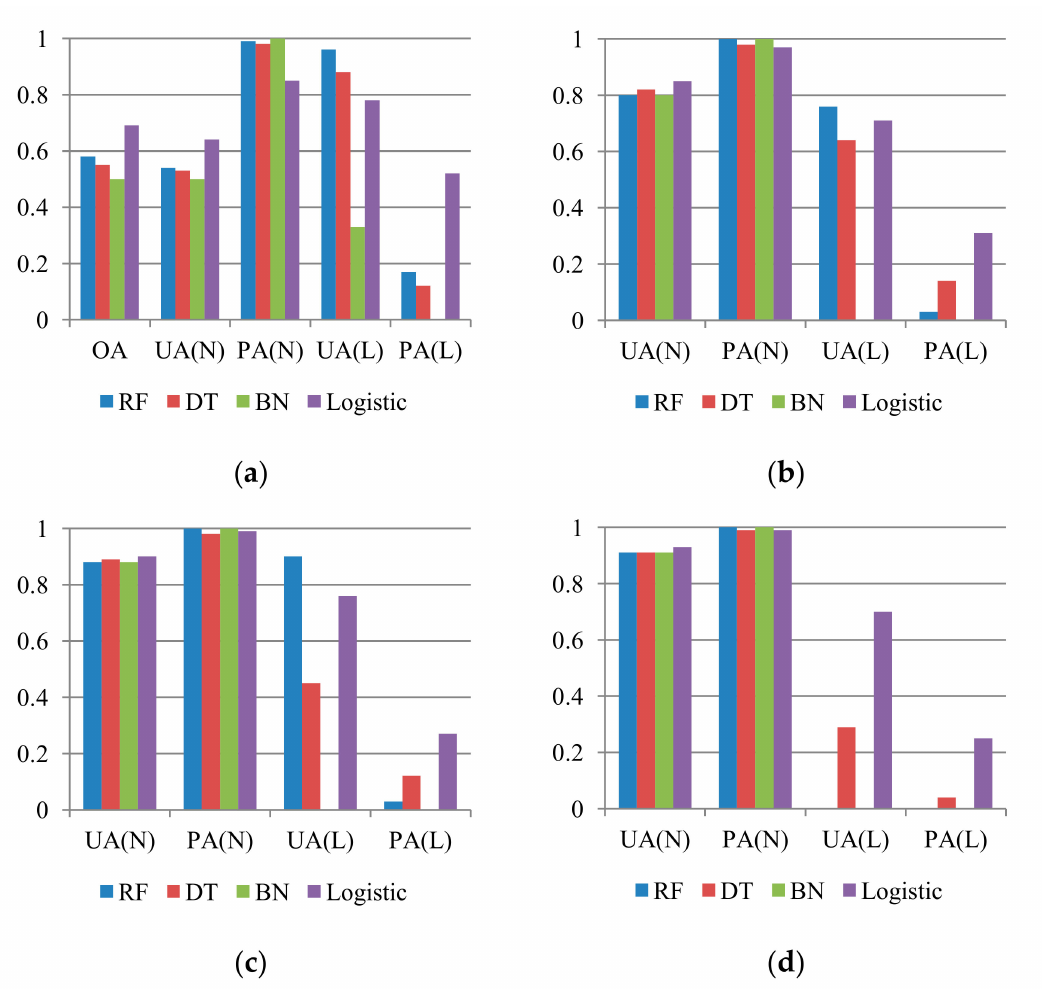
Figure 4. Time-robustness accuracies ( Y axis) for predicting the 2008 dataset, considering di ff erent algorithms and proportions of landslide (L) and non-landslide (N) classes, where RF, DT, BN, logistic, OA, UA, and PA represent random forests, decision tree, Bayes network algorithms, logistic regression, overall accuracy, user’s accuracy, and producer’s accuracy, respectively. ( a ) L:N = 1:1; ( b ) L:N = 1:4; ( c ) L:N = 1:7; ( d ) L:N =